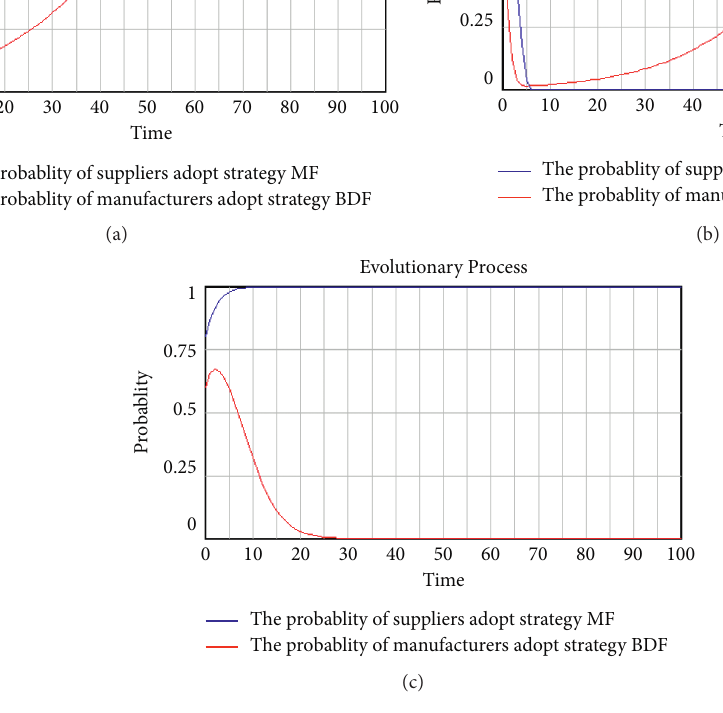
Figure 3: The evolutionary process.